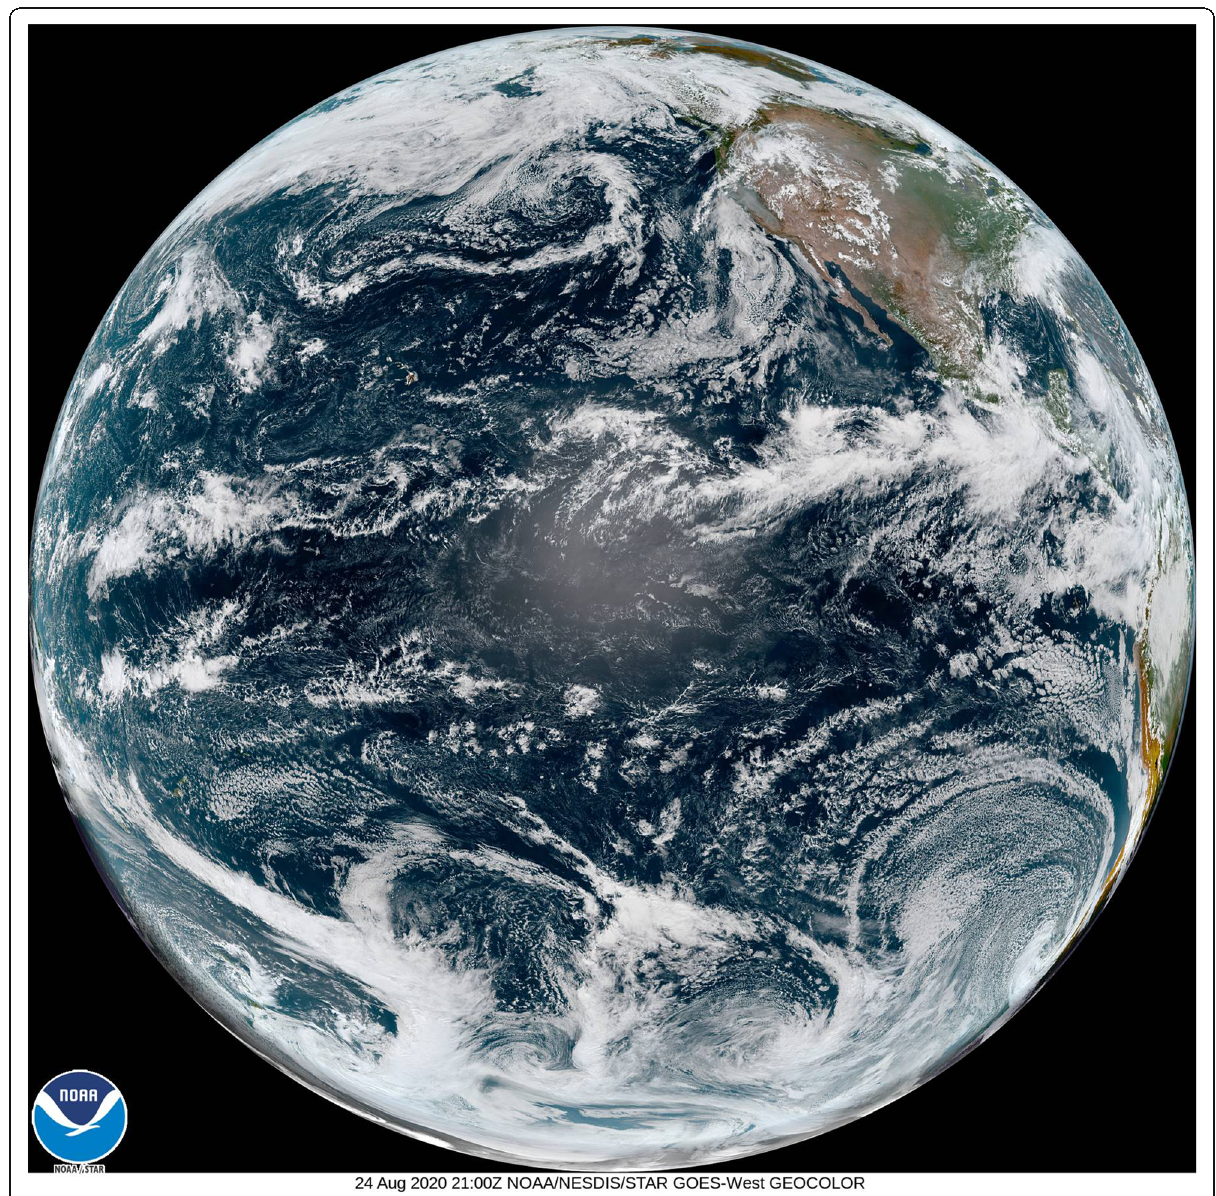
Fig. 26 This GOES-West image stretches from the western Pacific ocean to the western North America, and from just south of Alaska southward to Central America and the far western margin of Equador and Peru in South America. These disks map the Earth every 10 min at spatial resolutions from 500 m to 2 km and subsets are mapped even more rapidly. The data quality makes these data an exciting time series for study of diel